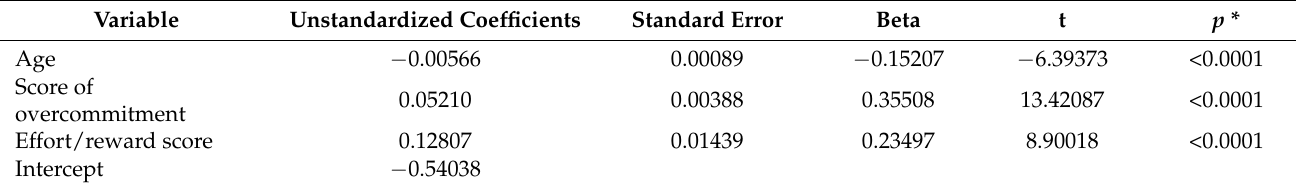
Table 4. Relation between the variables and high exhaustion score in flHCW.